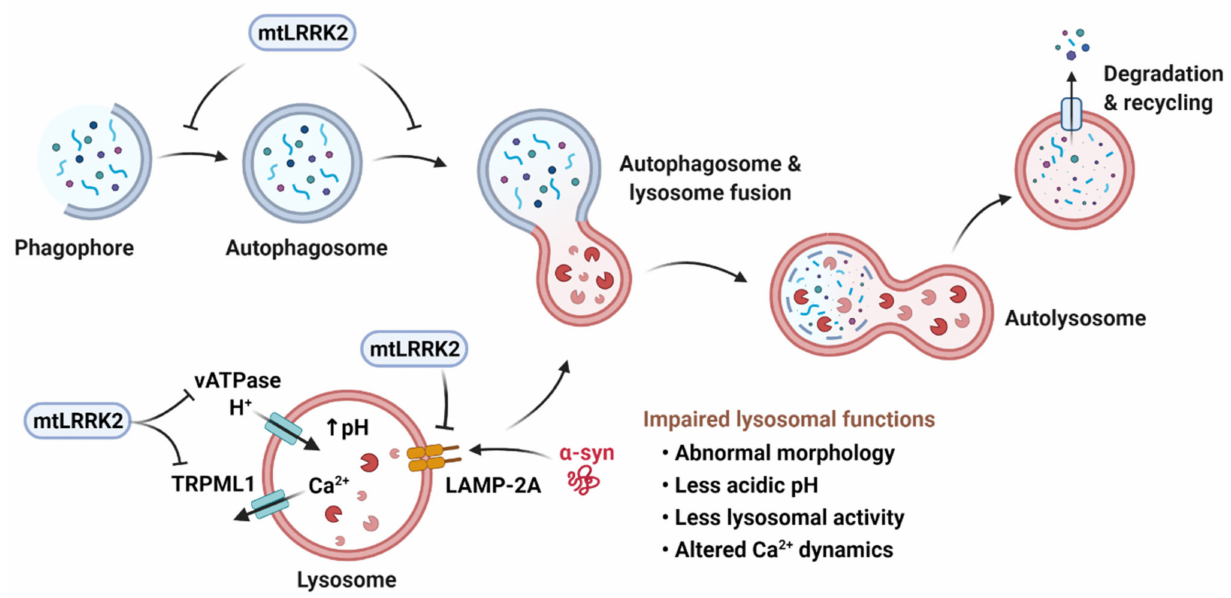
Figure 4. Pathogenic LRRK2 mutants (mtLRRK2) and the autophagy-lysosomal pathways. Macroautophagy is initiated by the formation of a cup-shaped membrane, termed phagophore, which engulfs damaged organelles or misfolded proteins to form the autophagosome. The autophagosome fuses with the lysosome and generates the autolysosome, in which the contents are degraded. Transition into autophagosome and autolysosome is inhibited by mtLRRK2. In chaperone-mediated autophagy, proteins are targeted to lysosomes by a chaperone through interaction between the chaperone and a pentapeptide present within the substrate. Substrate proteins then bind to a transmembrane receptor, lysosome-associated membrane protein type 2A (LAMP-2A), which multimerizes to form the translocation complex that carries the substrate proteins into the lysosome for degradation. LAMP-2A is inhibited by mtLRRK2, leading to the accumulation of CMA substrates, such as α -synuclein ( α -syn). mtLRRK2 can also decrease lysosomal acidity and disrupt lysosomal calcium dynamics by inhibiting lysosomal H+-ATPase pump, vATPase and TRPML1. Created with